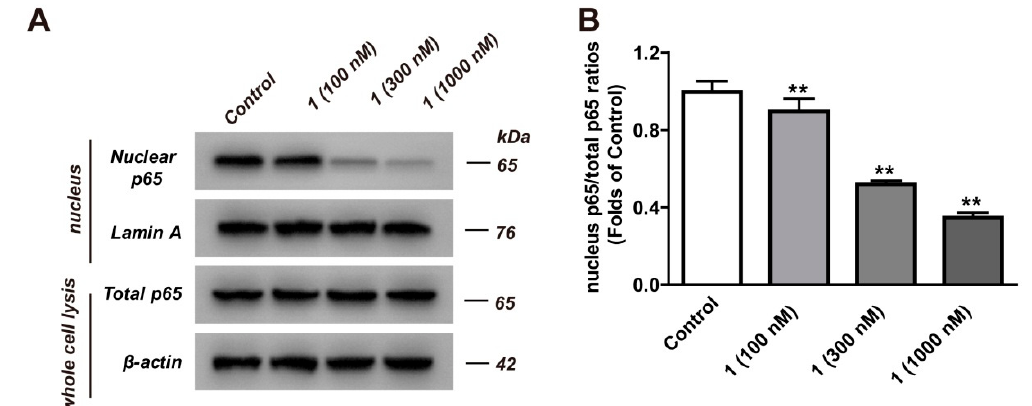
Figure 5. The effects of compound 1 on p65 nuclear translocation in HepG2 cells. HepG2 cells were cultured in the presence or absence of compound 1 (100, 300, 1000 nM) for 24 h. ( A ) The expression of total p65 and nuclear p65 were measured by Western blot assay, with β -actin or Lamin A serving as a loading control. ( B ) The results were normalized to the control group. Results are shown as mean ± SD for three individual experiments which, for each condition, were performed in triplicate. Compared with the control group, ** p < 0.01.